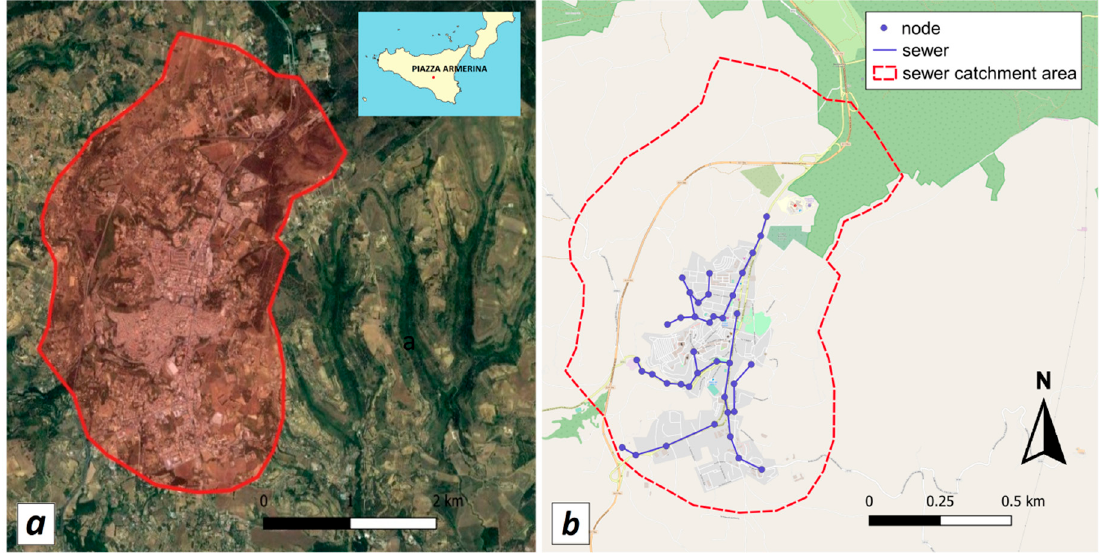
Figure 1. ( a ) Orthoimage of the area of study; ( b ) location of the urban drainage main pipes in the area of study.